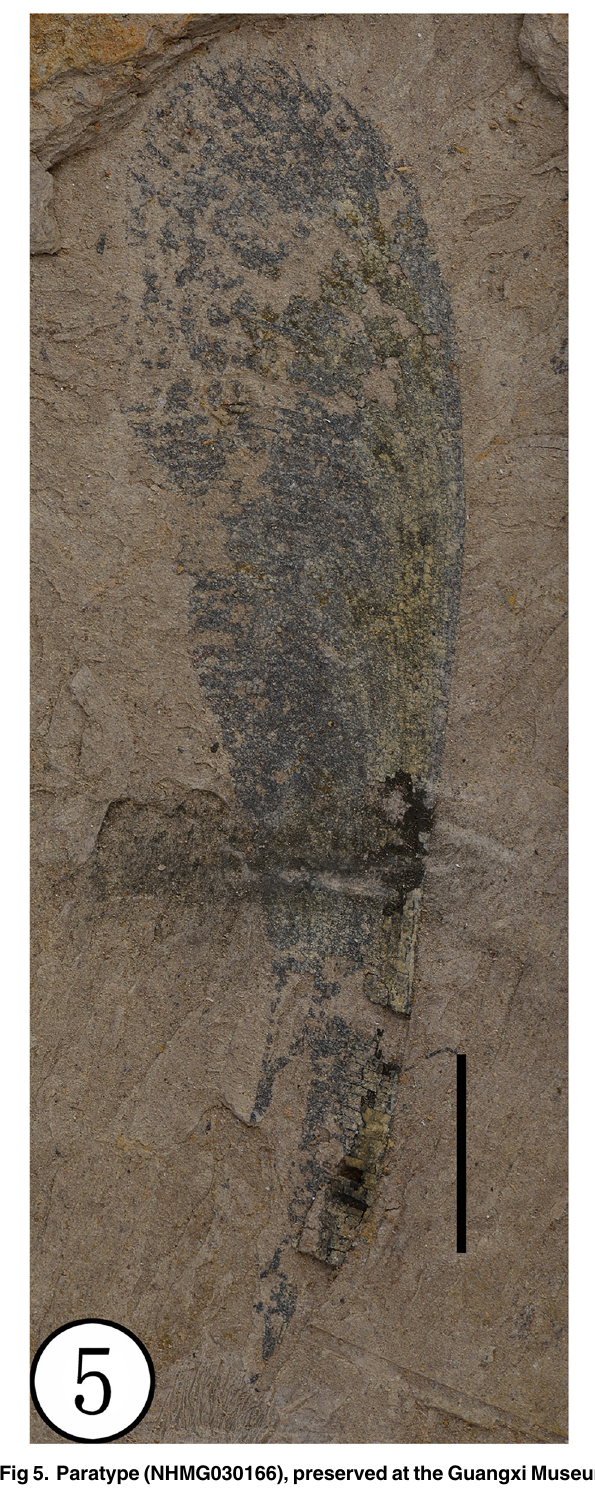
Fig 5. Paratype (NHMG030166), preserved at the Guangxi Museum of Natural History, China. Scale bar = 1 cm.